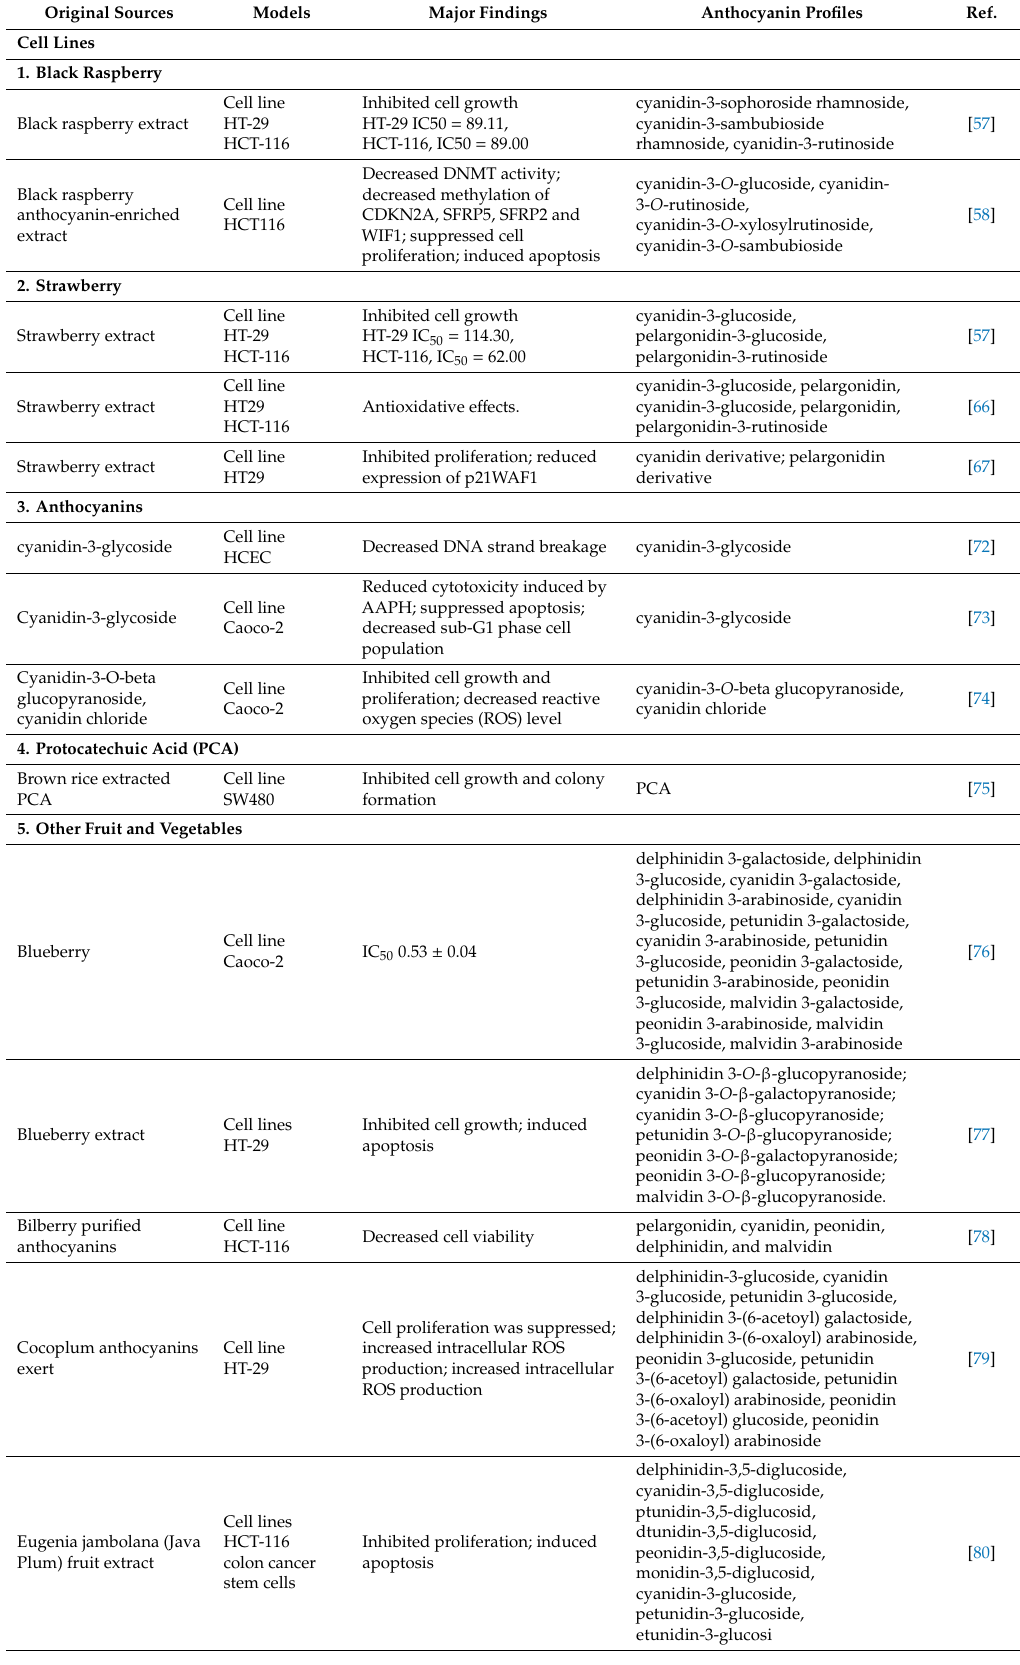
Table 3. E ff ects of anthocyanins in IBD and IBD-related